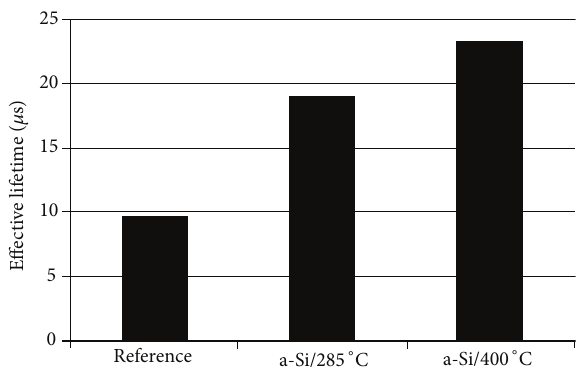
Figure 8: Effective lifetimes of the reference cell (reference), the cell with 5nm a-Si deposited on the rear side and annealed at 285 ∘ C (a- Si/285 ∘ C) and at 400 ∘ C (a-Si/400 ∘